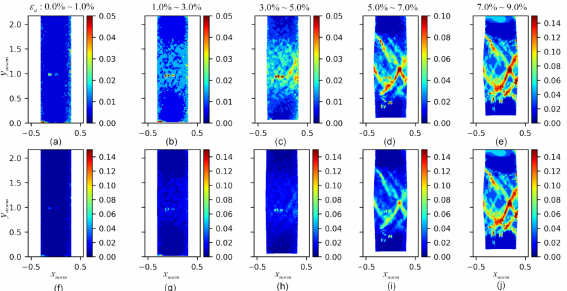
Figure 13. The evolution of the mean fields of ( curl U ) strains of 0.0–1.0%, 1.0–3.0%, 3.0–5.0%, 5.0–7.0%, and 7.0–9.0%, respectively, with varying range colormaps; ( f – j ) the mean fields of ( curl U ) and 7.0–9.0%, respectively, with consistent range colormaps.